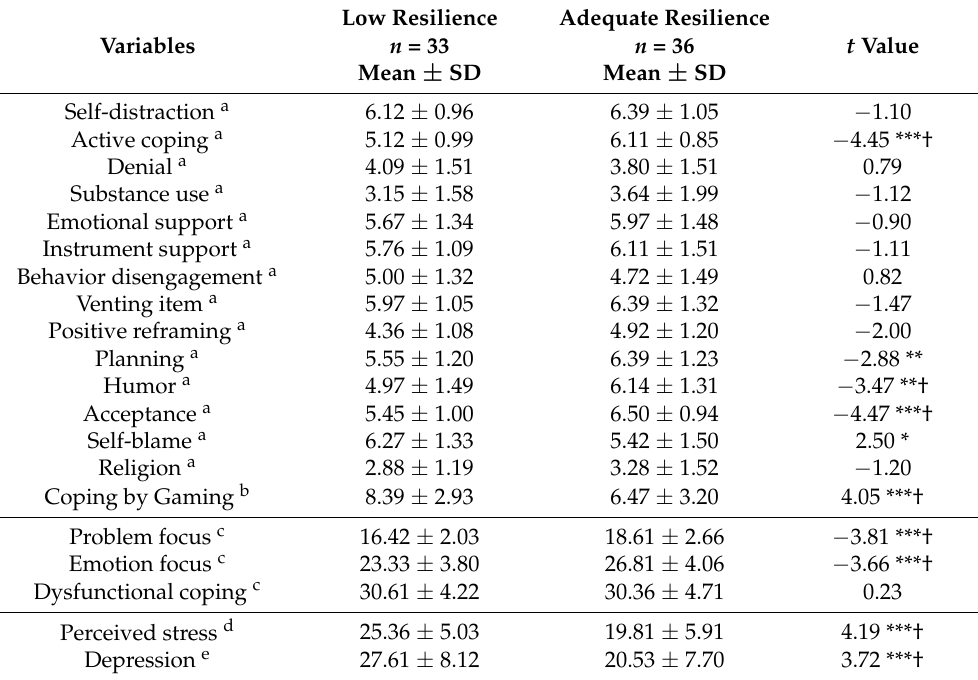
Table 5. Differences in coping strategy, perceived stress, and depression between individuals with low resilience and others in the internet gaming disorder